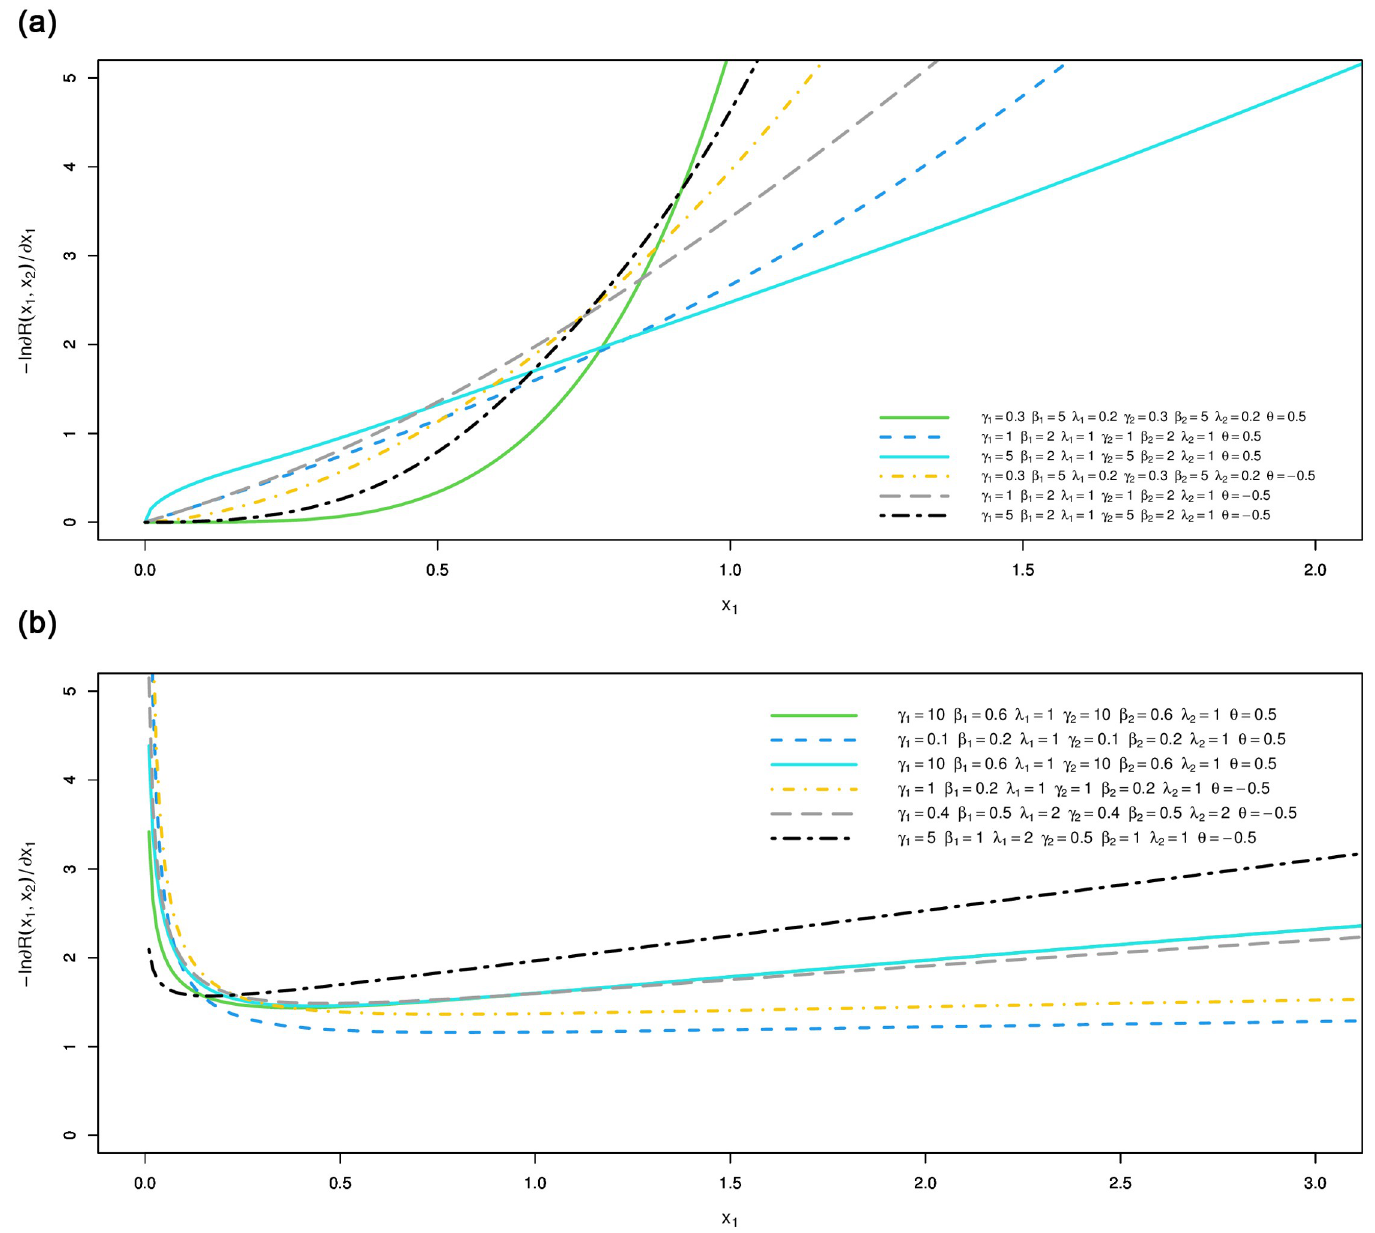
Fig 7. Possible shapes of the vector of the hrf for the BFGMPLx depending on x 1 for several values of parameters.